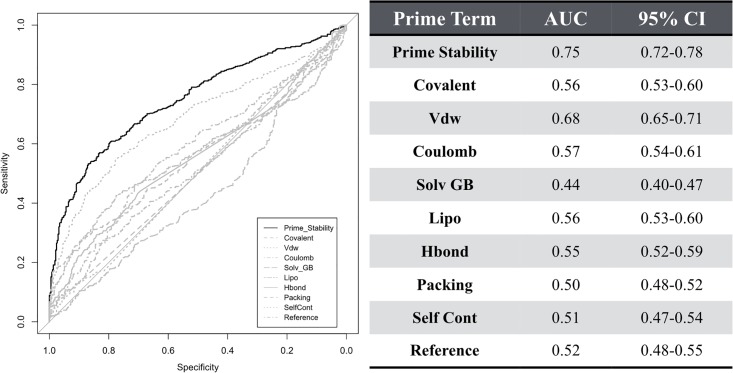
ROC curves for individual Prime terms on the beta lactamase dataset.The ROC curve for the Prime Stability energy function (black) and individual terms of the Prime Stability energy function (gray). The table on the right list the corresponding area under the curve (AUC) values and the 95% confidence intervals for the AUC values.